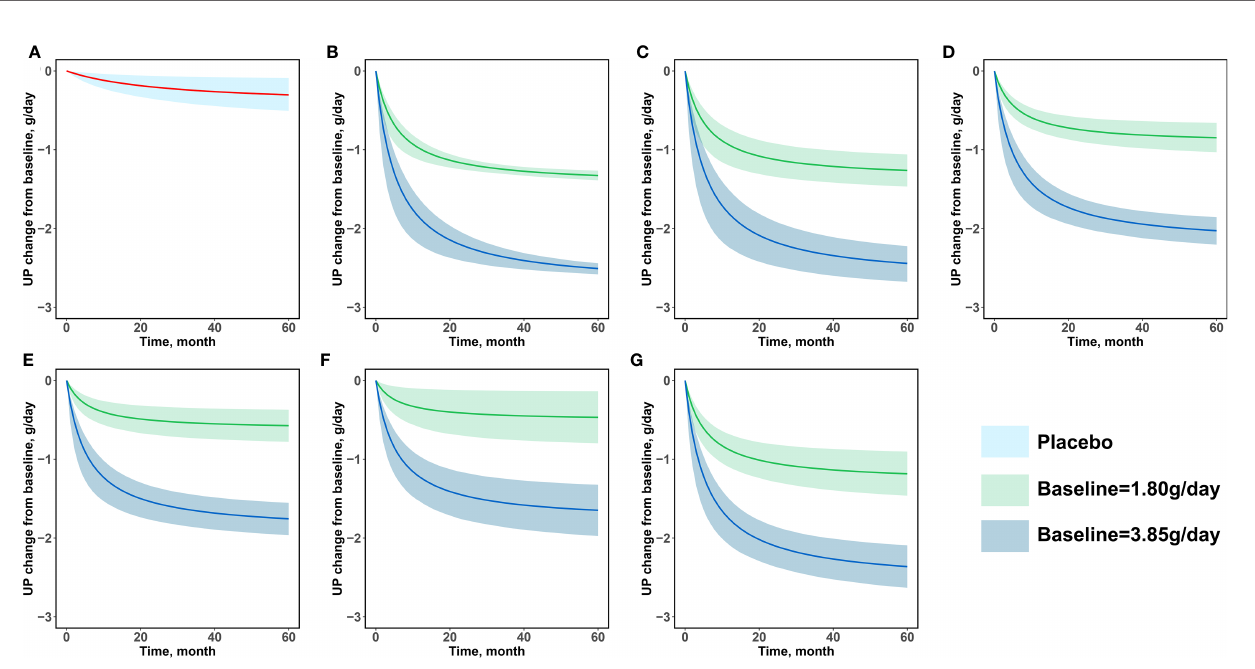
FIGURE 5 | Typical values and 95% con fi dence intervals for placebo and individual drug effects. (A) Placebo (B) Corticosteroids (C) Immunosuppressants (D) RAS blockers (E) Antiplatelet agents (F) N-3 fatty acids (G) Other